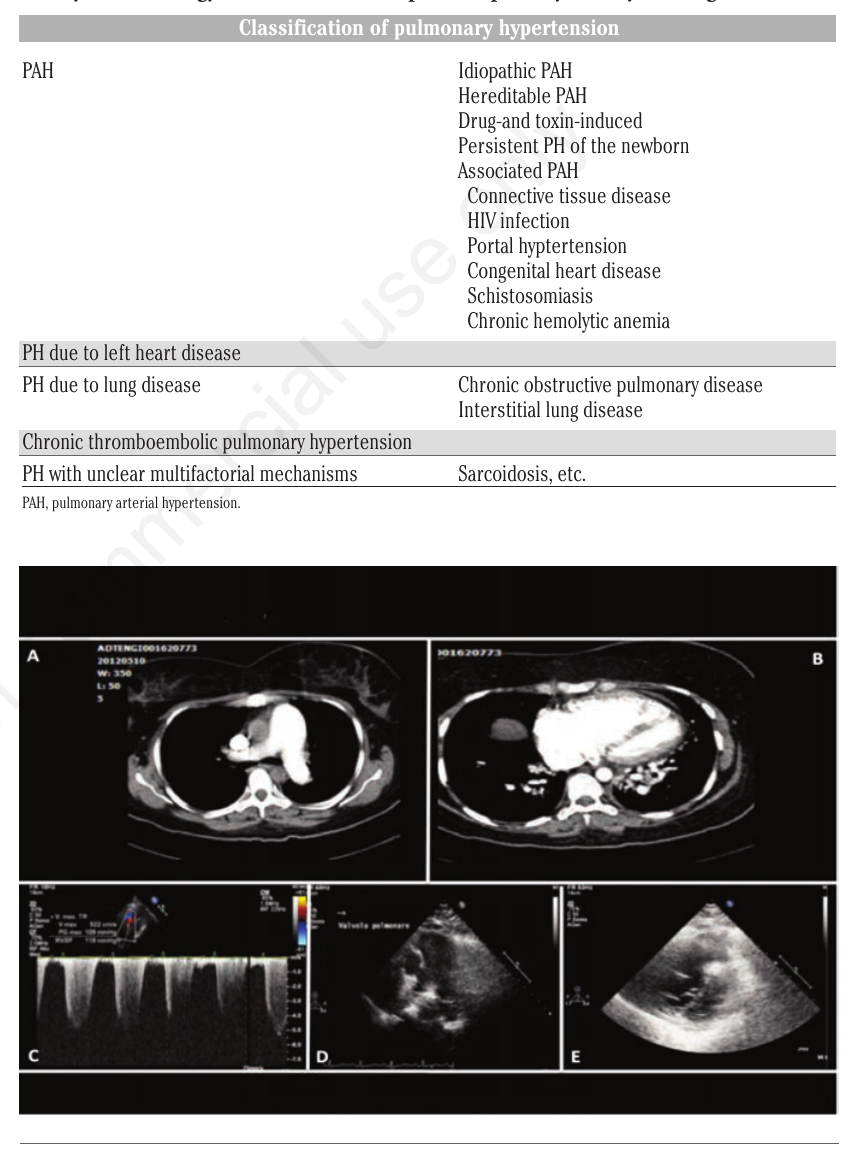
Figure 1. Cardiac imaging. A) and B) Computed tomography scans demonstrating severe idiopathic pulmonary arterial hypertension. Note the markedly enlarged pulmonary trunk with tiny branching smaller vessels. C) A transthoracic echocardiogram revealed a right ventricular systolic pressure of 96 mm/Hg. D) A pulmonary artery trunk measuring up to 38 mm was detected. E) Dilatation of right chambers: right atrium was 57 mm in diameter; right ventricle wall measurement was 10